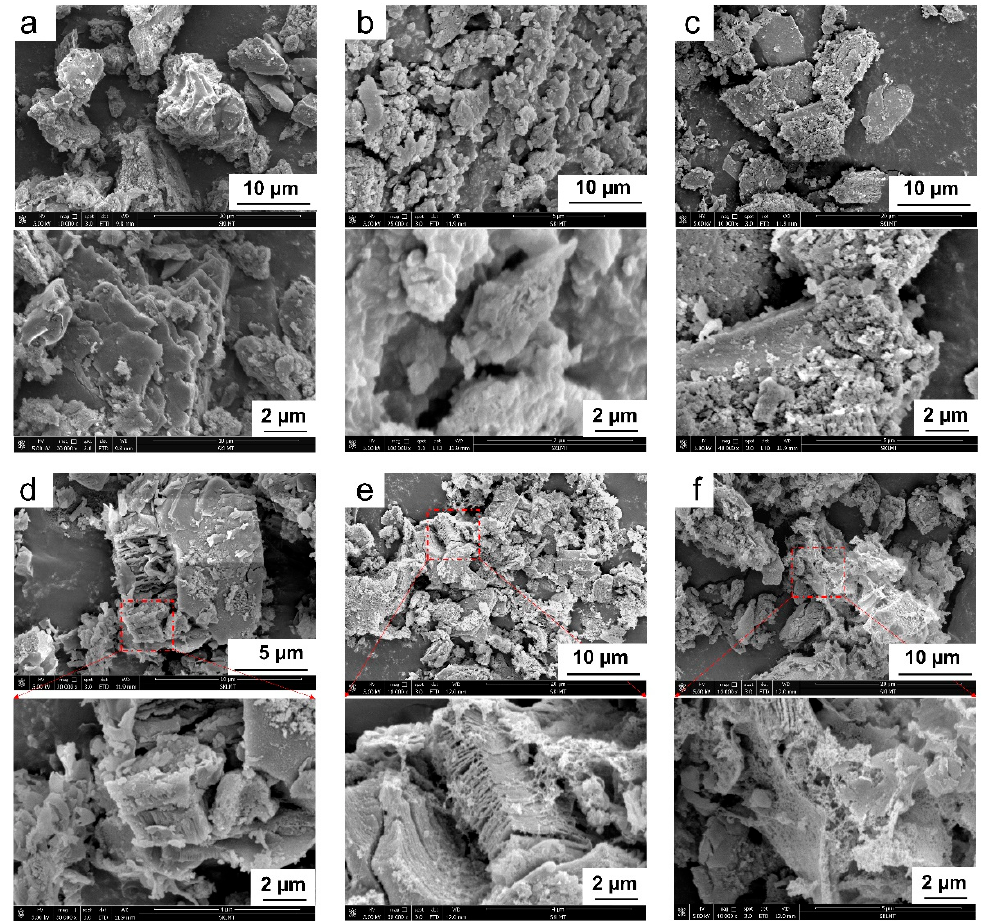
Figure 4. SEM images of different samples: ( a ) TBCN, ( b ) 0TC-TBCN, ( c ) 1TC-TBCN, ( d ) 2.5TC-TBCN, ( e ) 5TC-TBCN and ( f ) 10TC-TBCN.